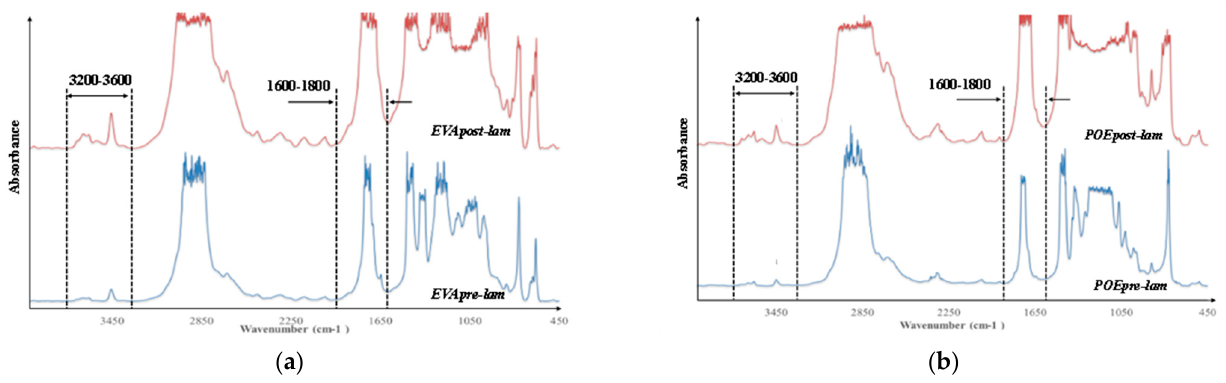
Figure 6. FTIR spectra of ( a ) EVApre-lam and EVApost-lam and ( b ) POEpre-lam and POEpost-lam commercial samples.